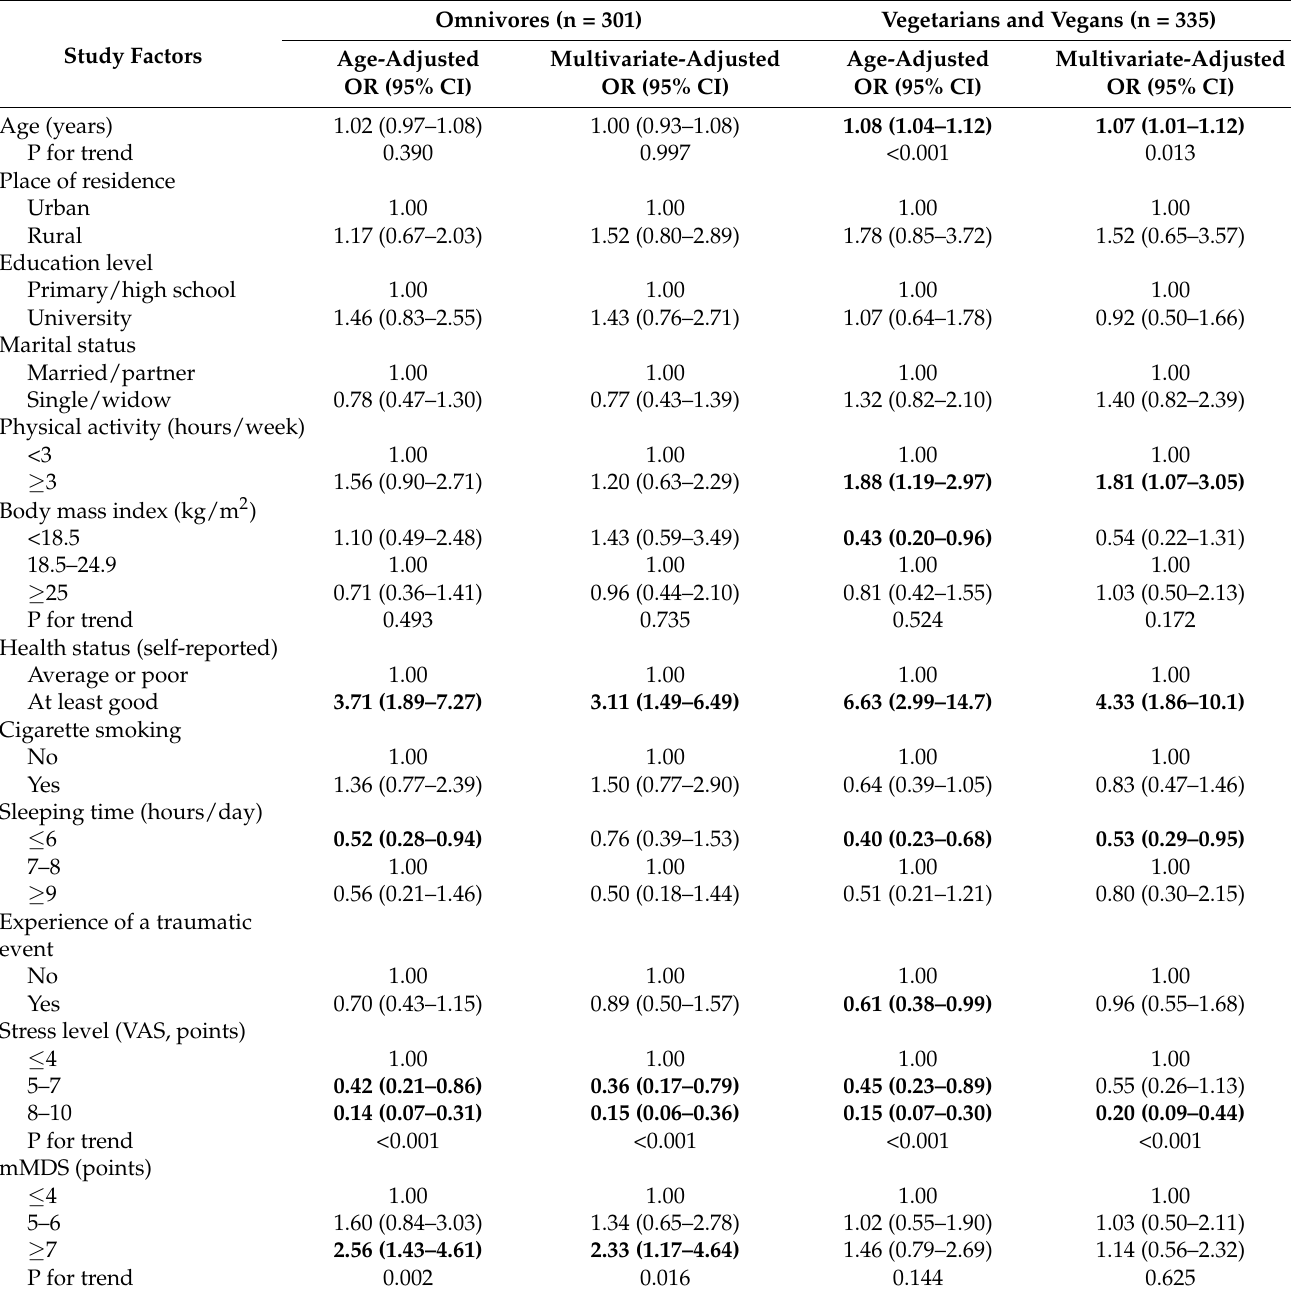
Table 4. The logistic regression of good well-being by socio-demographic and lifestyle determinants in